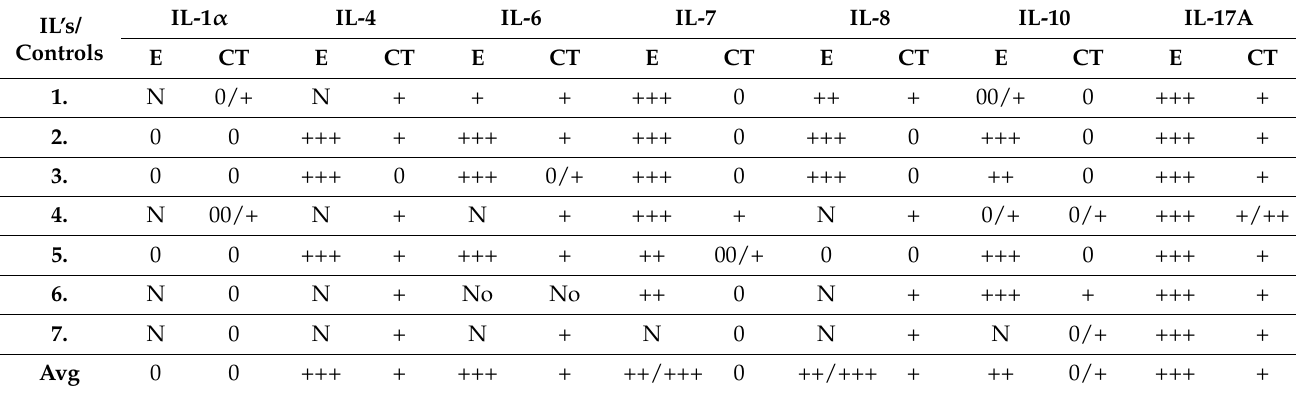
Table 2. Number of interleukin positive cells in the gallbladder epithelium and connective tissue of control samples. IL’s/ Controls